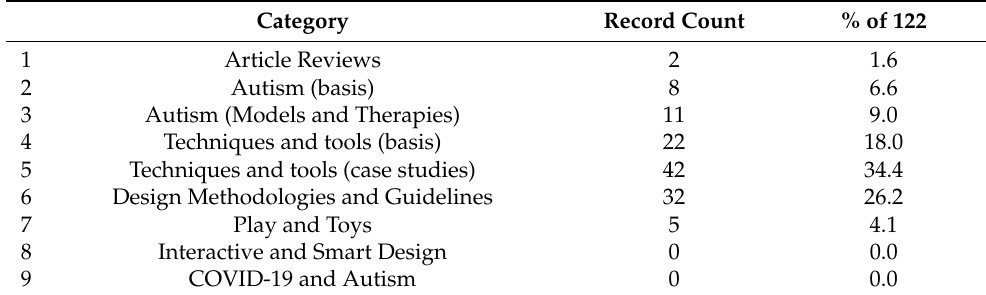
Table 8. Resources focused on the collaboration of people with autism for each